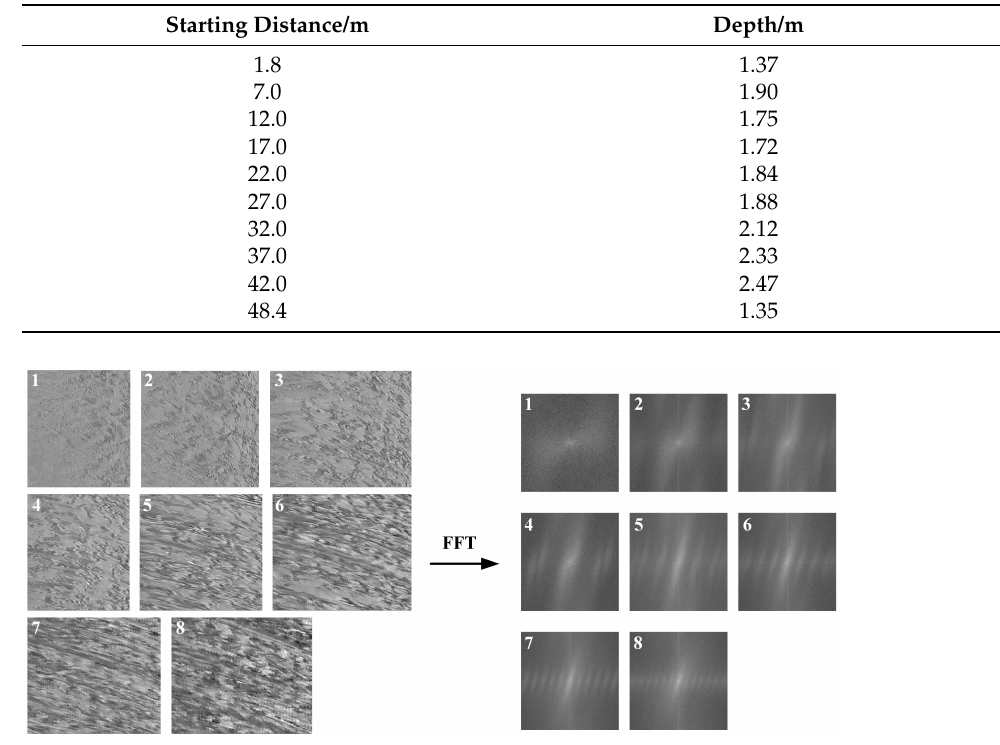
Figure 16. STIs and their FFT images obtained at Baoji hydrographic